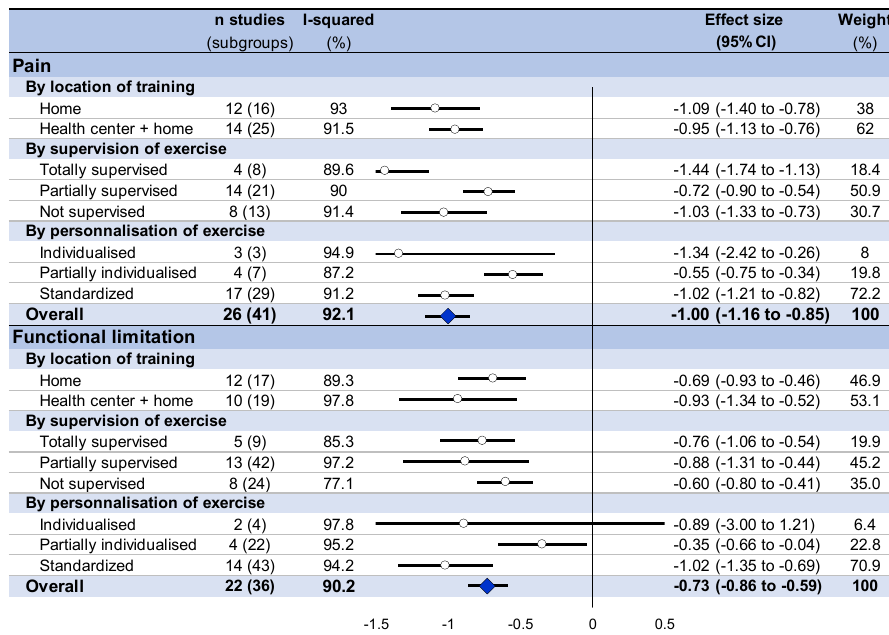
Figure A4. Summary of meta-analysis on the effect of home-based exercise on pain intensity and functional limitation, stratified by setting (exclusive home-based training versus home-based and other settings, supervision, and standardization of training), using only the last time of follow-up.